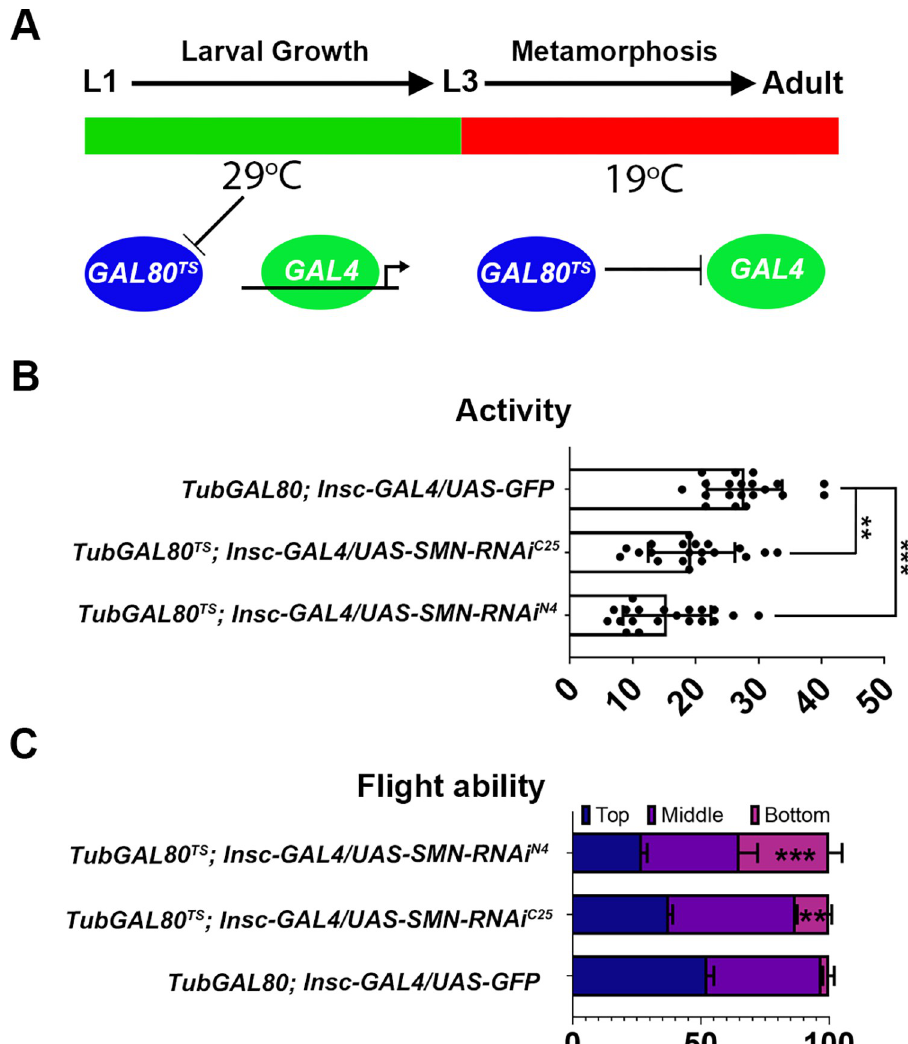
Fig 4. Adult motor defects persist with developmentally targeted spatiotemporal survival motor neuron (SMN) knockdown. (A) The GAL80 TS system was used to eliminate any adult GAL4 expression. Larvae were reared at 29˚C (GAL80 TS is inactive; GAL4 is active) and then switched to 19˚C (GAL80 TS is active; GAL4 is repressed) during pupation; (B and C) two non-overlapping RNAi constructs were used (SMN-RNAi N4 and SMN-RNAi C25 ) for flight and activity defects. Both (B) activity (SMN-RNAi N4 , ��� P < 0.001; SMN-RNAi C25 , �� P < 0.01, n = 20, Kruskal–Wallis test with Dunn’s multiple comparisons) and (C) flight defects (SMN-RNAi N4 , ��� P < 0.001; SMN-RNAi C25 , �� P < 0.01, n = 40; Kruskal–Wallis test with Dunn’s multiple comparisons) were detected using this